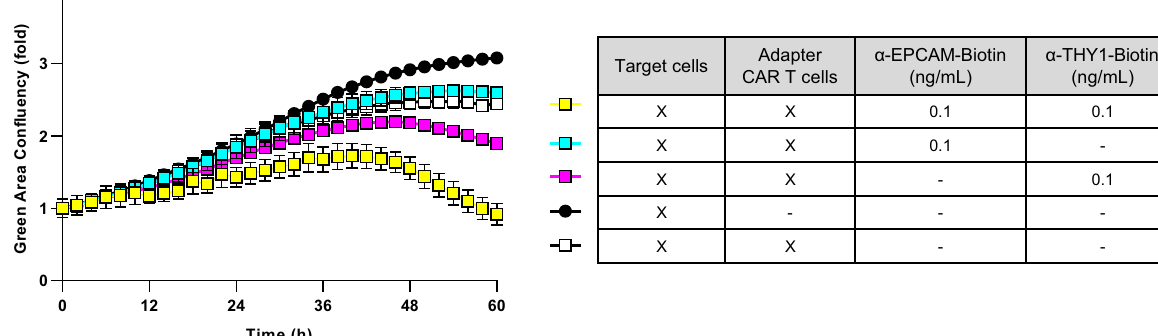
Figure 7. Adapter CAR T cells targeting THY1 and EPCAM are selectively cytolytic against ovarian cancer cell line co-expressing THY1 and EPCAM. Primary human T cells were isolated and transduced with a CAR construct against biotin. Anti-biotin CAR T cells were co-cultured with THY1-, EPCAM-, and GFP- expressing target cells for 72 h in the presence of suboptimal single adapter doses or with the combinatorial use of suboptimal adapter doses. GFP-fluorescence was measured over time. CAR T cell-mediated lysis of target cells resulted in decreased GFP-fluorescence. Combined treatment with THY1- and EPCAM=reactive adapter antibodies triggered target cell lysis at concentrations which were too low to cause CAR T cell-mediated target cell lysis when applied separately. Each data point represents mean of a technical replicate ± SEM. Representative graph from three experiments